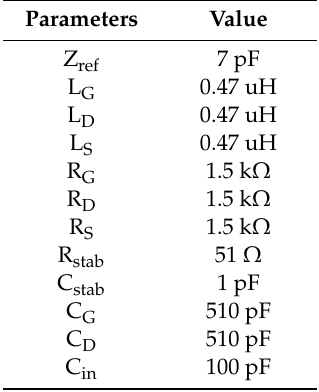
Table 1. Parameters of the non-Foster circuit.